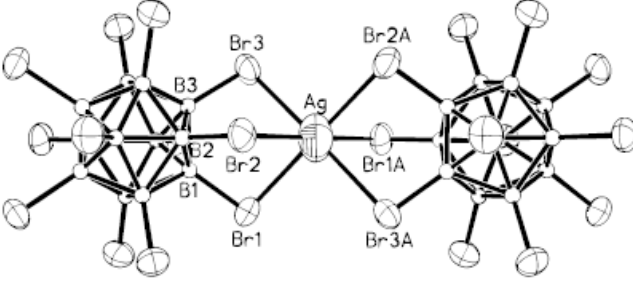
Figure 76. Fragment of X-ray structure of {Ag[1-Me-1-CB 11 Br 11 ]} n . Reprinted with permission from reference [98]. Copyright © (1998) American Chemical Society.